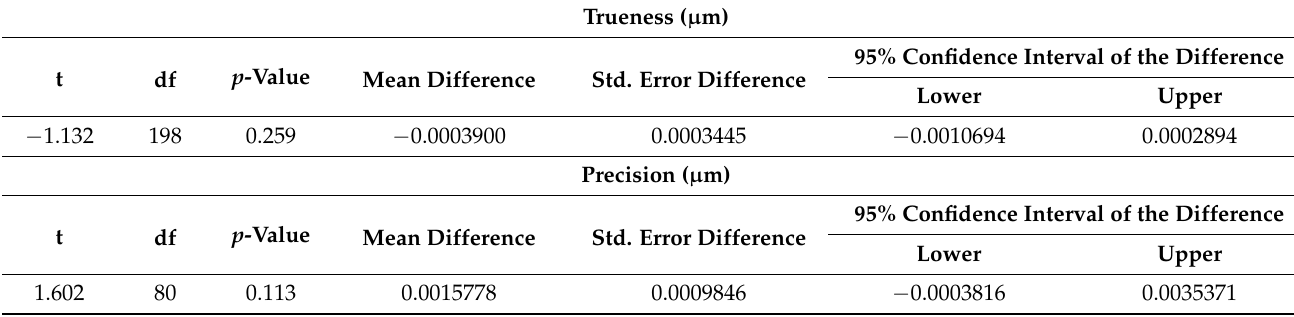
Table 2. Mean difference in trueness and precision between two different programs of superimposition (Geomagic Control X and Medit